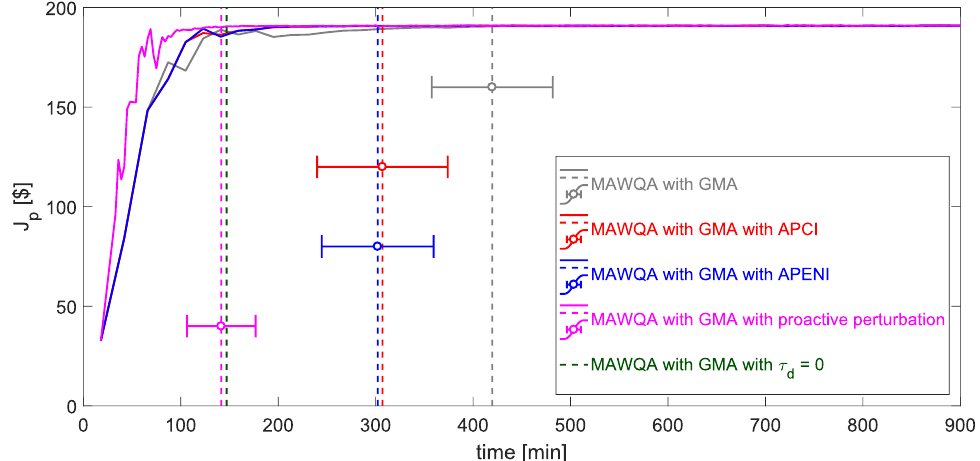
Figure 8. Williams–Otto reactor case study: evolution of mean profit function (solid line), mean time of convergence (vertical dashed line), and standard deviation of the time of convergence. Parameters of criterion for convergence are listed in Table